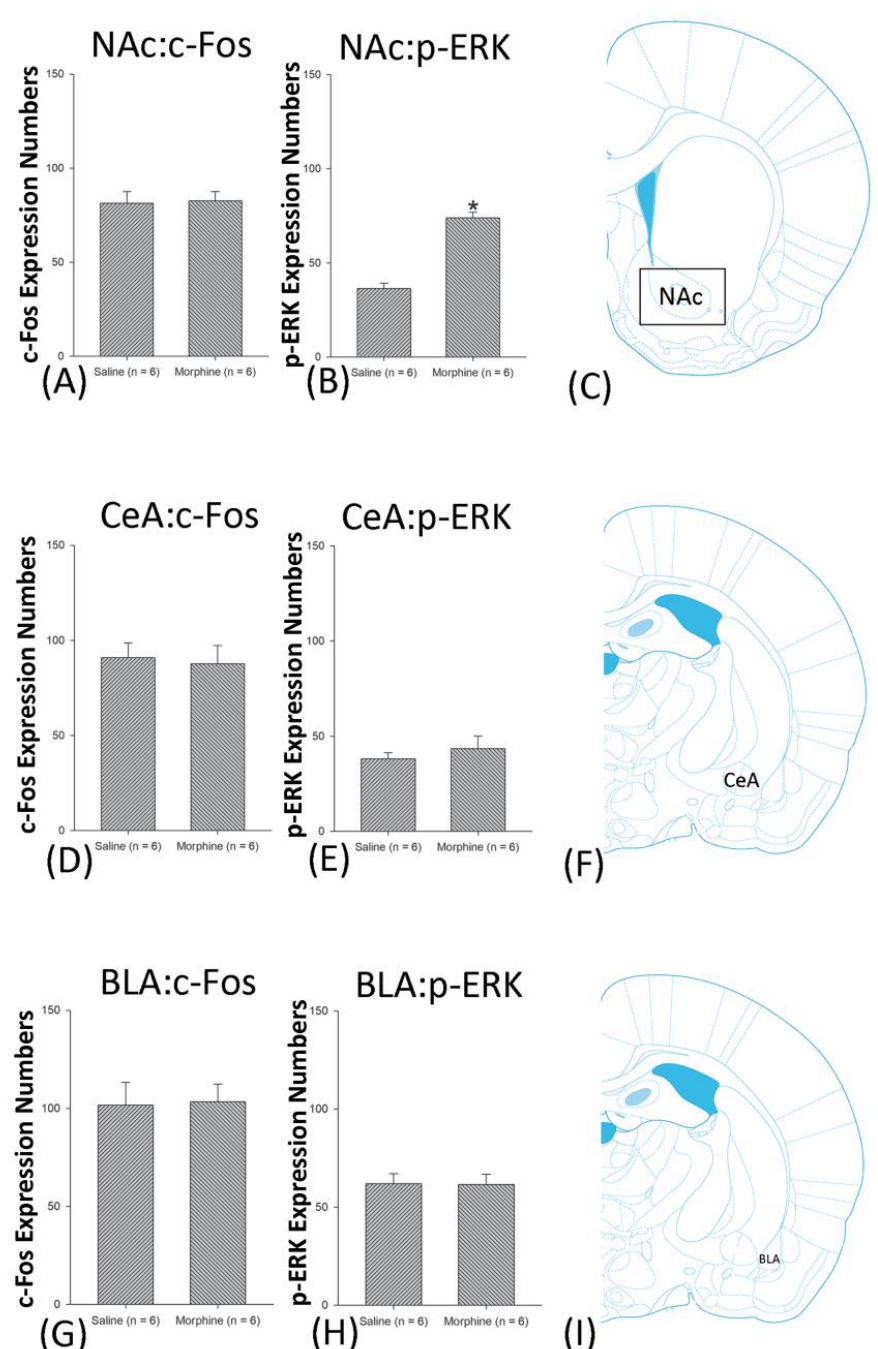
Figure 11. Nucleus accumbens (NAc), central amygdala (CeA), and basolateral amygdala (BLA) express c-Fos or p-ERK proteins in extinction. ( A ) c-Fos and ( B ) p-ERK expression in NAc, ( D ) c-Fos and ( E ) p-ERK expression in the CeA, and ( G ) c-Fos and ( H ) p-ERK expression in the BLA for extinction. ( C , F , I ) indicate a schematic representation of the NAc, CeA, and BLA. * p < 0.05 when comparing the saline and morphine groups ( n = 6 per group).